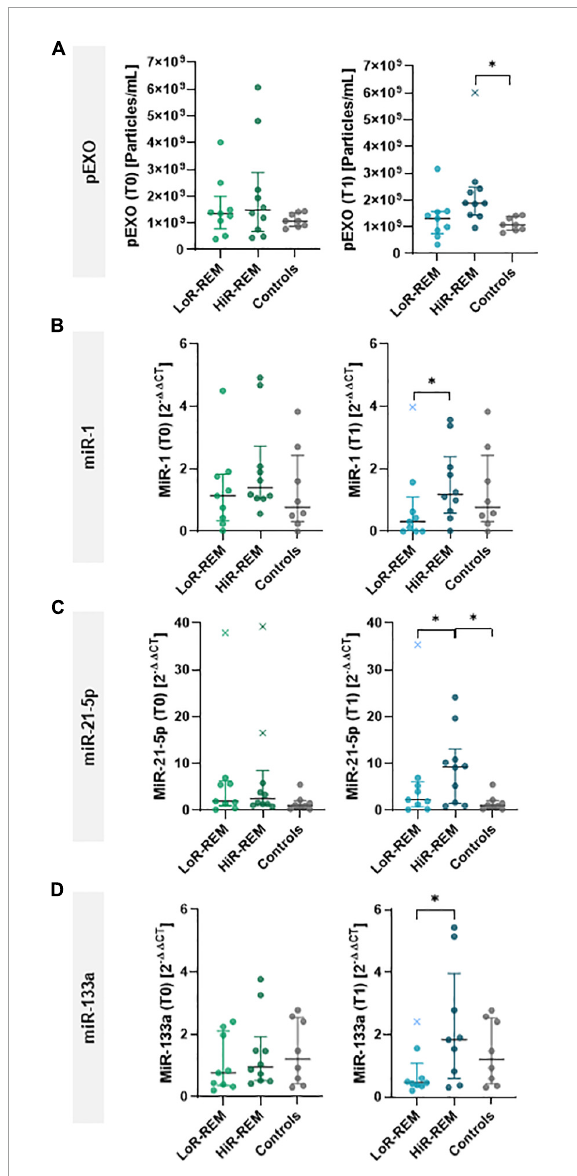
FIGURE4 Analysis of pEXOs and exosomal miRNA in MR patients with different grade of reverse remodeling after MVR surgery. The pEXOs were isolated from plasma of MR patients ( n = 19) collected before (T0) and 6 months after MVR surgery (T1); pEXOs isolated from healthy controls ( n = 8) were used as control. (A) Isolated pEXOs were quantified by NTA as described in the methods. (B–D) Exosomal miRNA-1 (B) , miRNA-21-5p (C) and miRNA-133a (D) were quantified through qRT-PCR. Preoperative (T0) and postoperative (T1) levels were compared between LoR-REM and HiR-REM patients. Individual values are shown in the graphs; bars represent median and interquartile range. Statistical significance of the differences between patients’ groups was evaluated by independent samples Student’s t -test (with or without Welch’s correction) or the Mann–Whitney test depending on data distribution. Statistical differences between patients and controls were evaluated by one-way ANOVA (with or without Brown–Forsythe modification for heteroscedastic groups) or the Kruskal–Wallis test, depending on sample distribution; ∗ p <